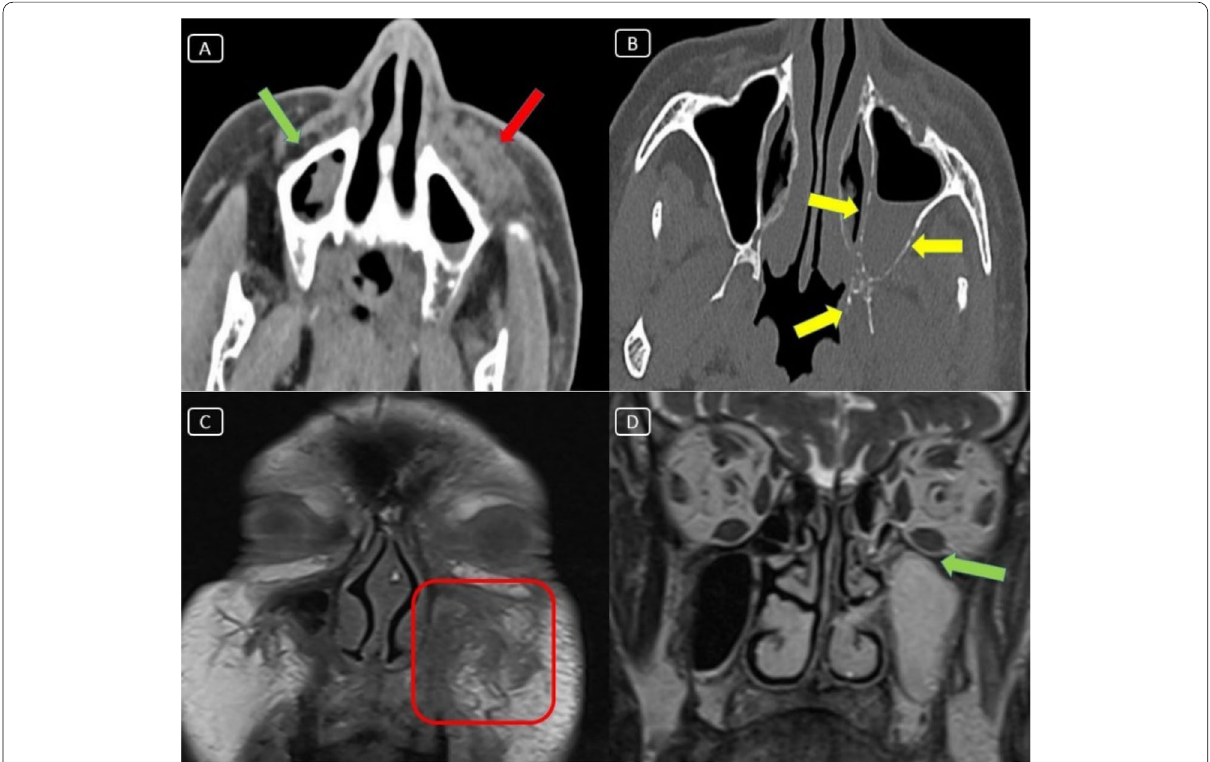
Fig. 3 A , B Axial CT cuts of the paranasal sinuses and orbital regions revealed (1) soft tissue fullness replacing the left pre‑maxillary antral fat (red arrow), (2) mild antral mucosal thickening, and (3) thinning out of the medial and lateral maxillary bony walls with areas of dehiscence and rarefaction that extended posteriorly up to the root of the pterygoid plates (yellow arrows). C Coronal T1WI MRI of the paranasal sinuses revealed asymmetrical fullness and heterogeneous signal intensity of the premaxillary fat (red square). D Coronal T2WI MRI of the paranasal sinuses and orbital regions revealed left maxillary sinusitis still with clear peri‑orbital fat planes (green